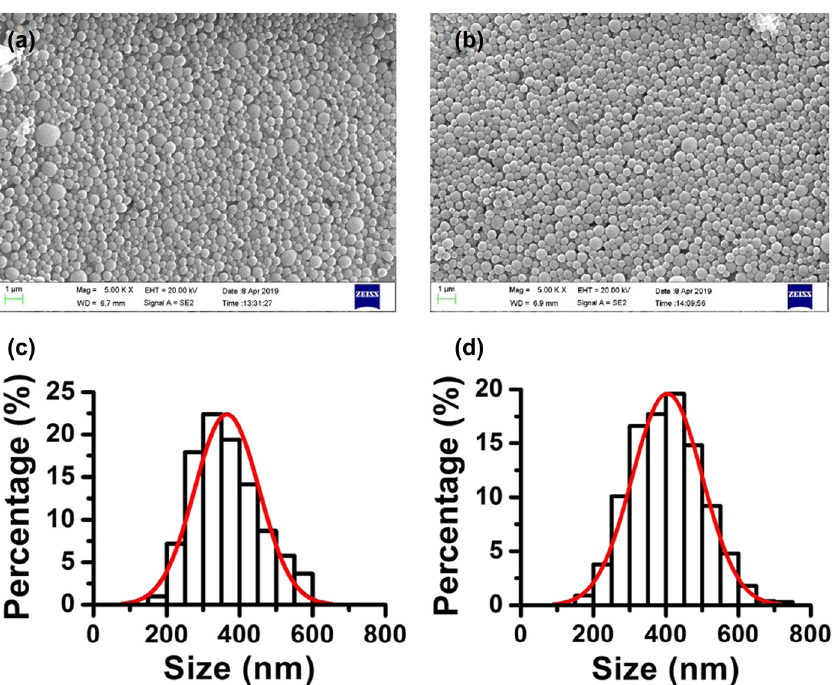
Figure 3: Morphology of MNPs and Em - MNPs. SEM images of MNPs ( a ) and Em - MNPs ( b ) . Diameter distributions of MNPs ( c ) and Em - MNPs ( d ) counted in SEM